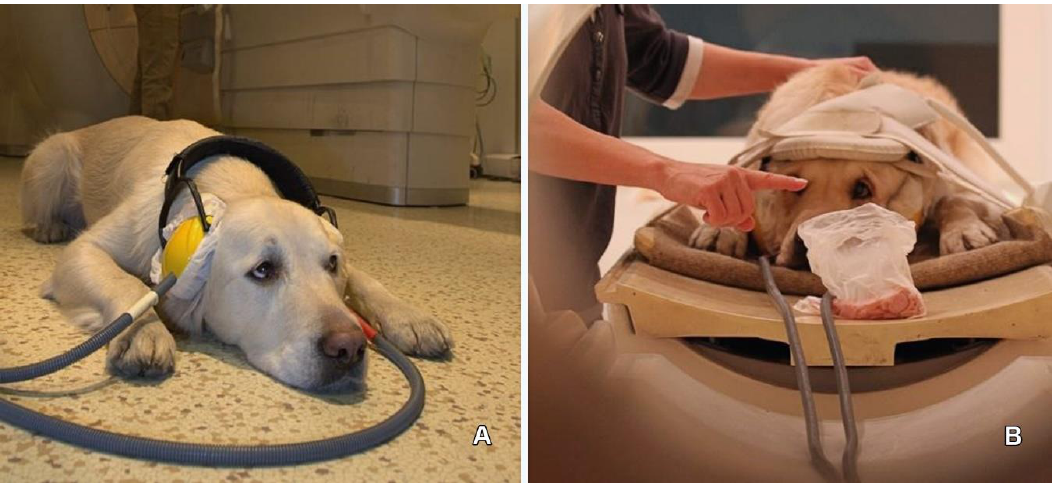
Figure 2. Training of the dogs. During training, getting used to the headphones ( A ), and in the MR scanner, learning to keep eye contact while lying motionless with headphones and the receiver coil secured ( B